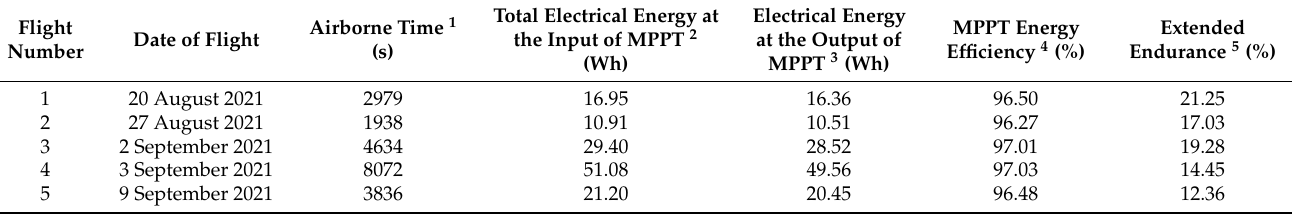
Table 2. Results of the MPPT